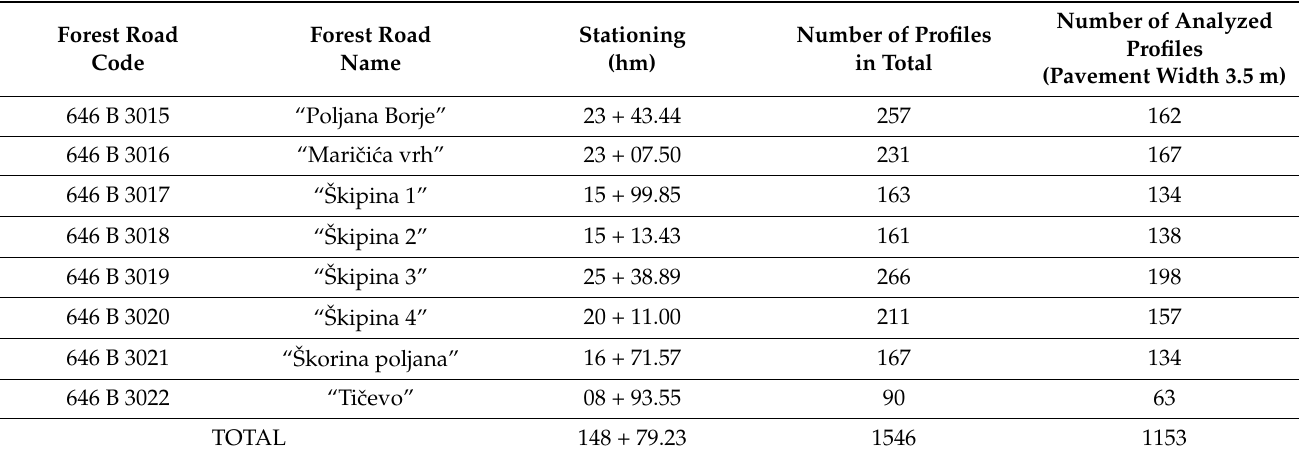
Table 1. Forest road stationing and number of total/analyzed